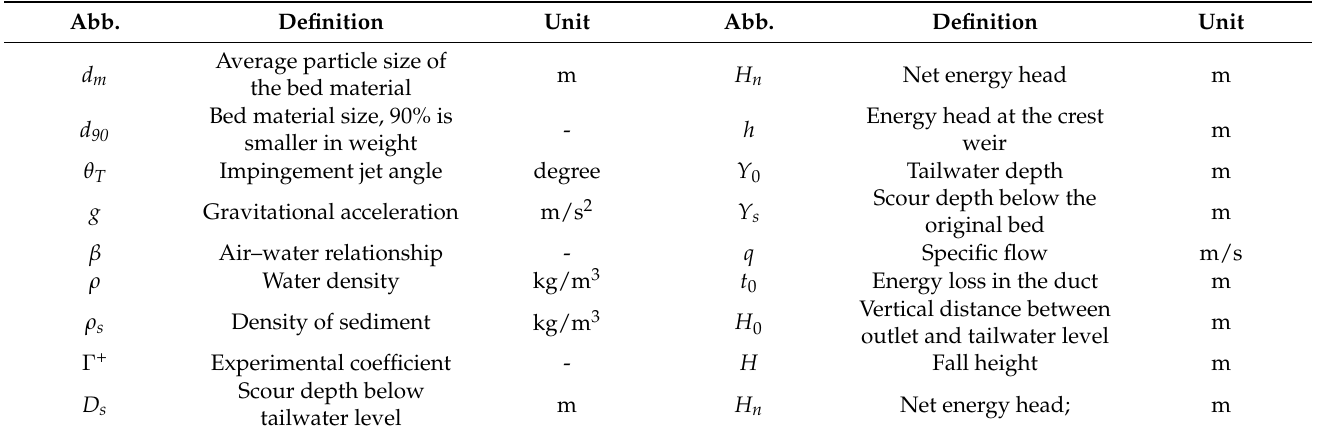
Table 6. Symbol notation list of the plunge pool semi-theoretical